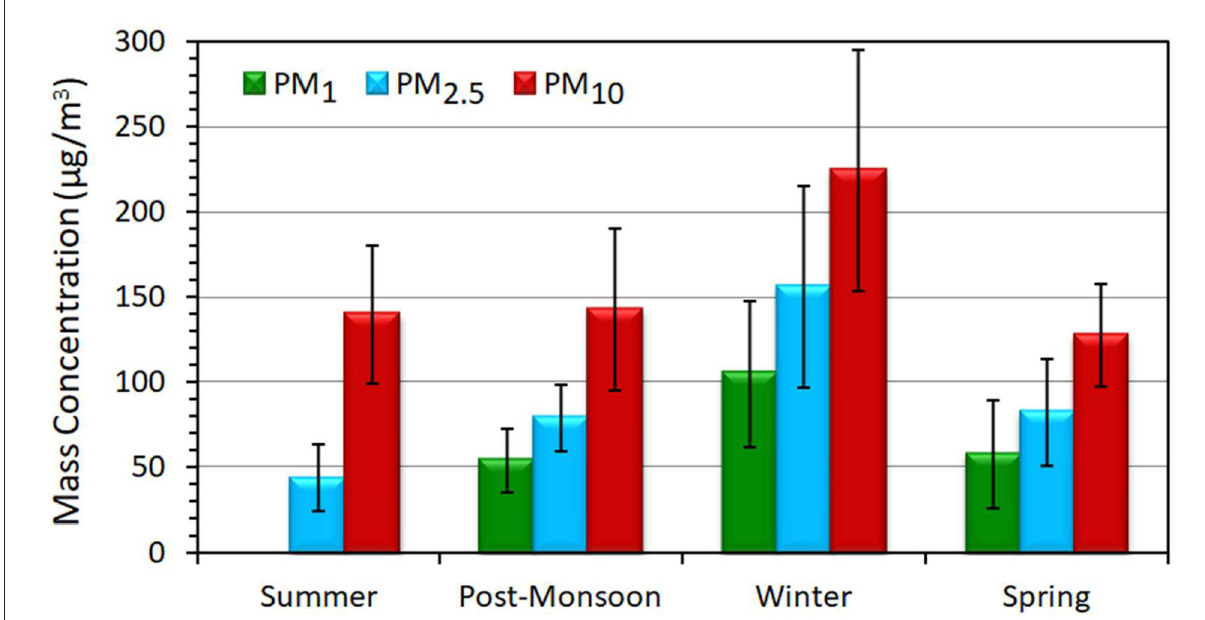
FIGURE3 Seasonal variation in mass concentration of particulate matter (PM 1 , PM 2.5 , and PM 10 ) from April 2019 to March 2020 over Varanasi.